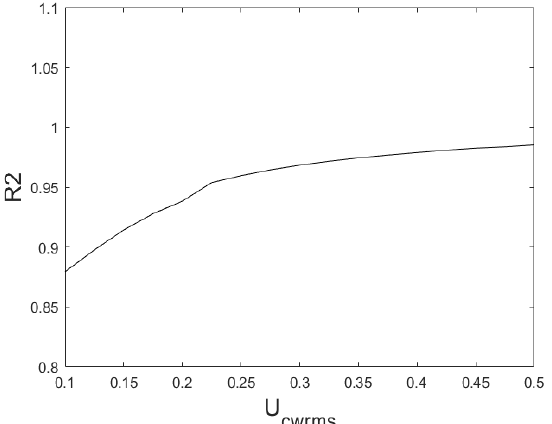
Figure 3. Three-dimensional nonlinear to two-dimensional nonlinear ratio, R2, versus U cwrms .